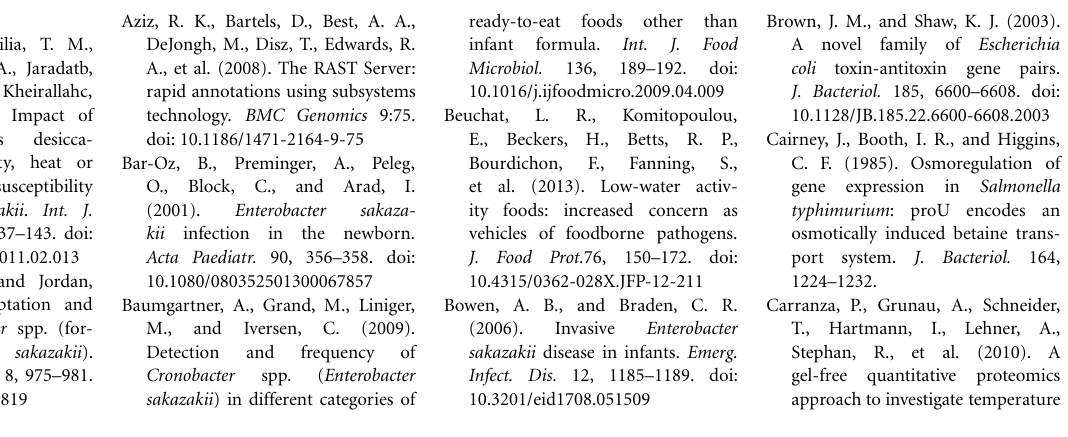
Table S11 | Iron acquisition systems identified in the chromosome of C. sakazakii